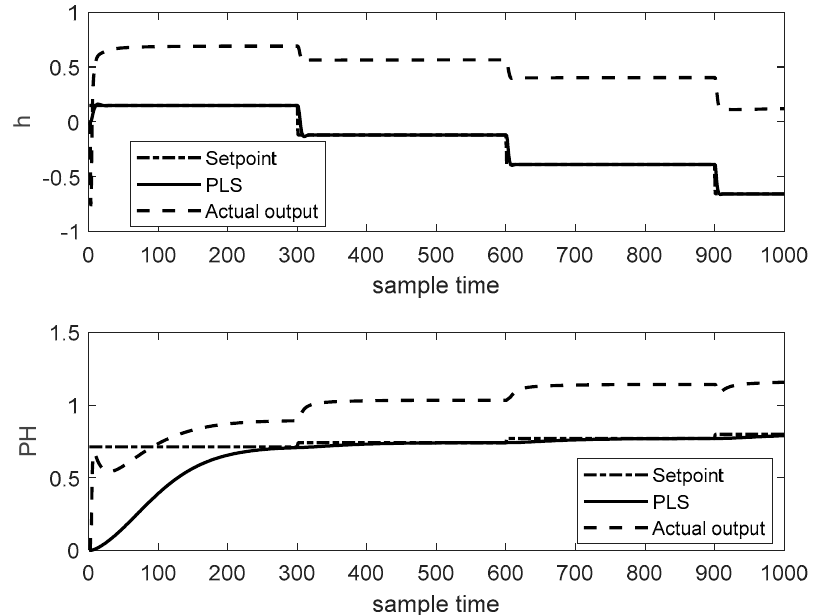
Figure 6. Results of the conventional method in latent variable space.